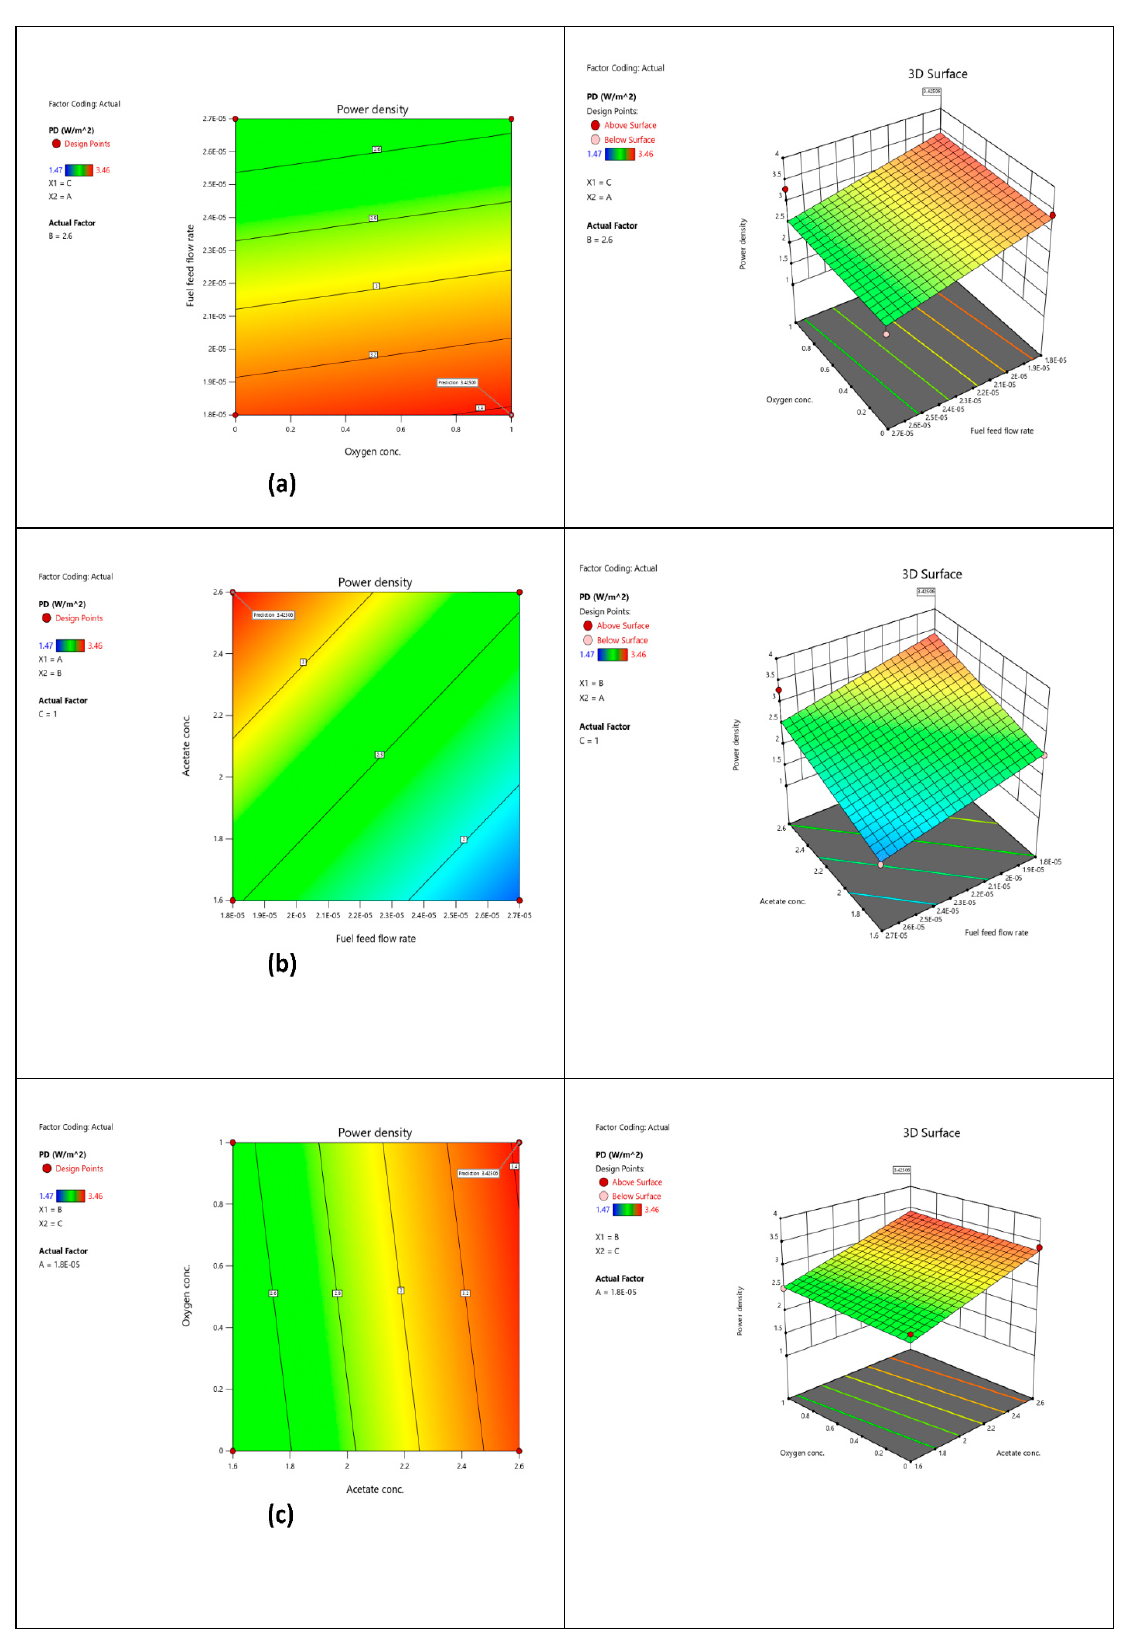
Figure 2. Contour plots of optimization to study the effect of the selected independent parameters on the MFC power density: ( a ) Effect of oxygen concentration and fuel feed flowrate, ( b ) effect of fuel feed flowrate and acetate concentration, and ( c ) effect of acetate concentration and oxygen